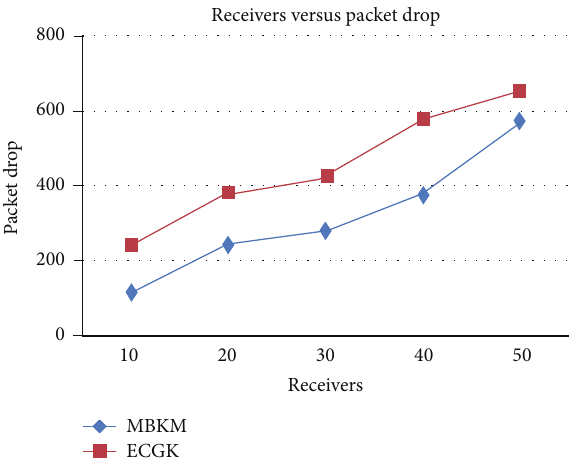
Figure 12: Comparison of packet drop with ECGK for varying receivers.